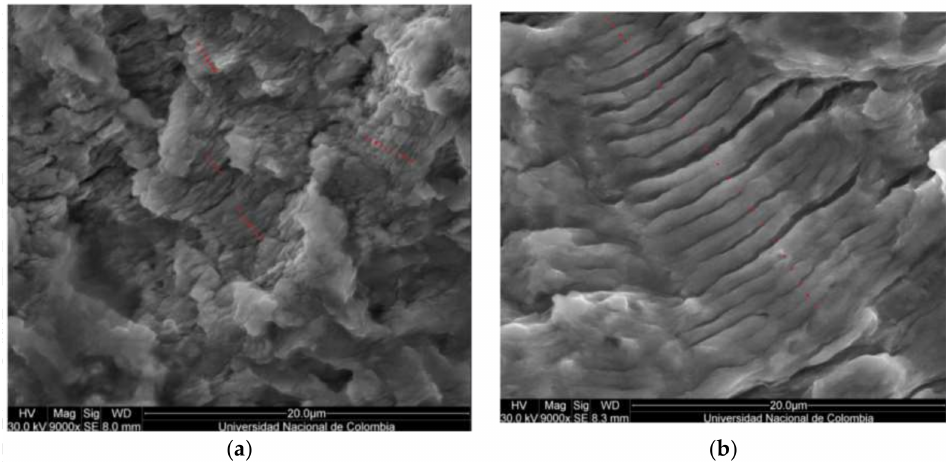
Figure 15. Striation counting close to the crack origin and close to the end of stable crack propagation for specimen 3F-H. ( a ) Position 0–0.001 m, 3.48 × 10 − 7 m/cycle (9000 × ); ( b ) Position 0.004–0.0054 m, 1.17 × 10 − 6 m/cycle (9000 × ).